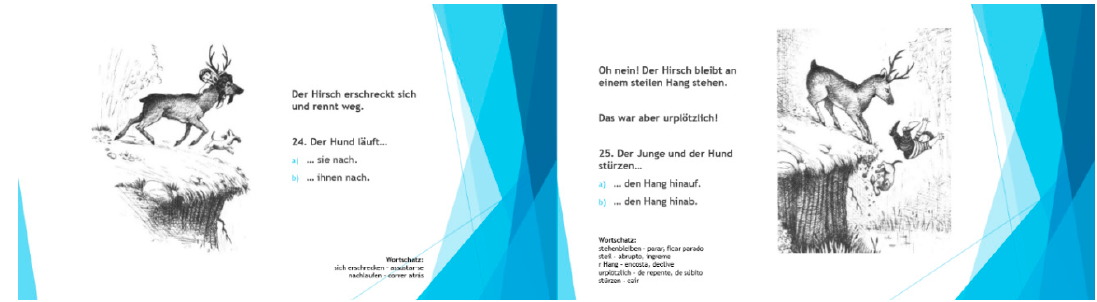
Figure A37. Posttest: Binary-choice recognition task.